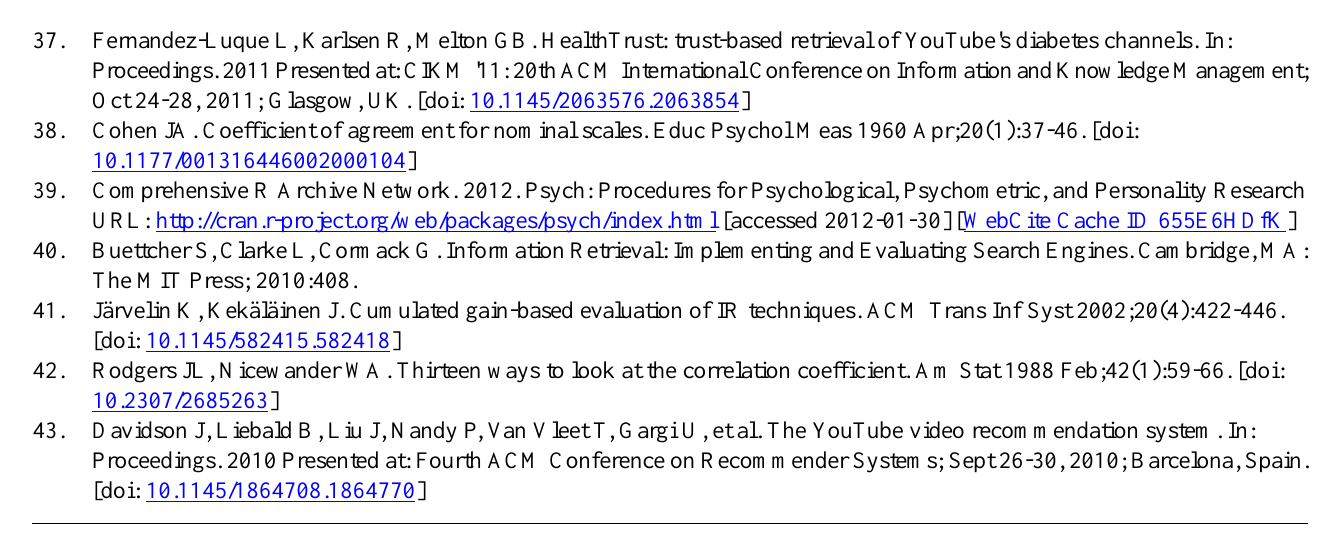
API: application programming interface DCG: discounted cumulative gain CDC: Centers for Disease Control and Prevention